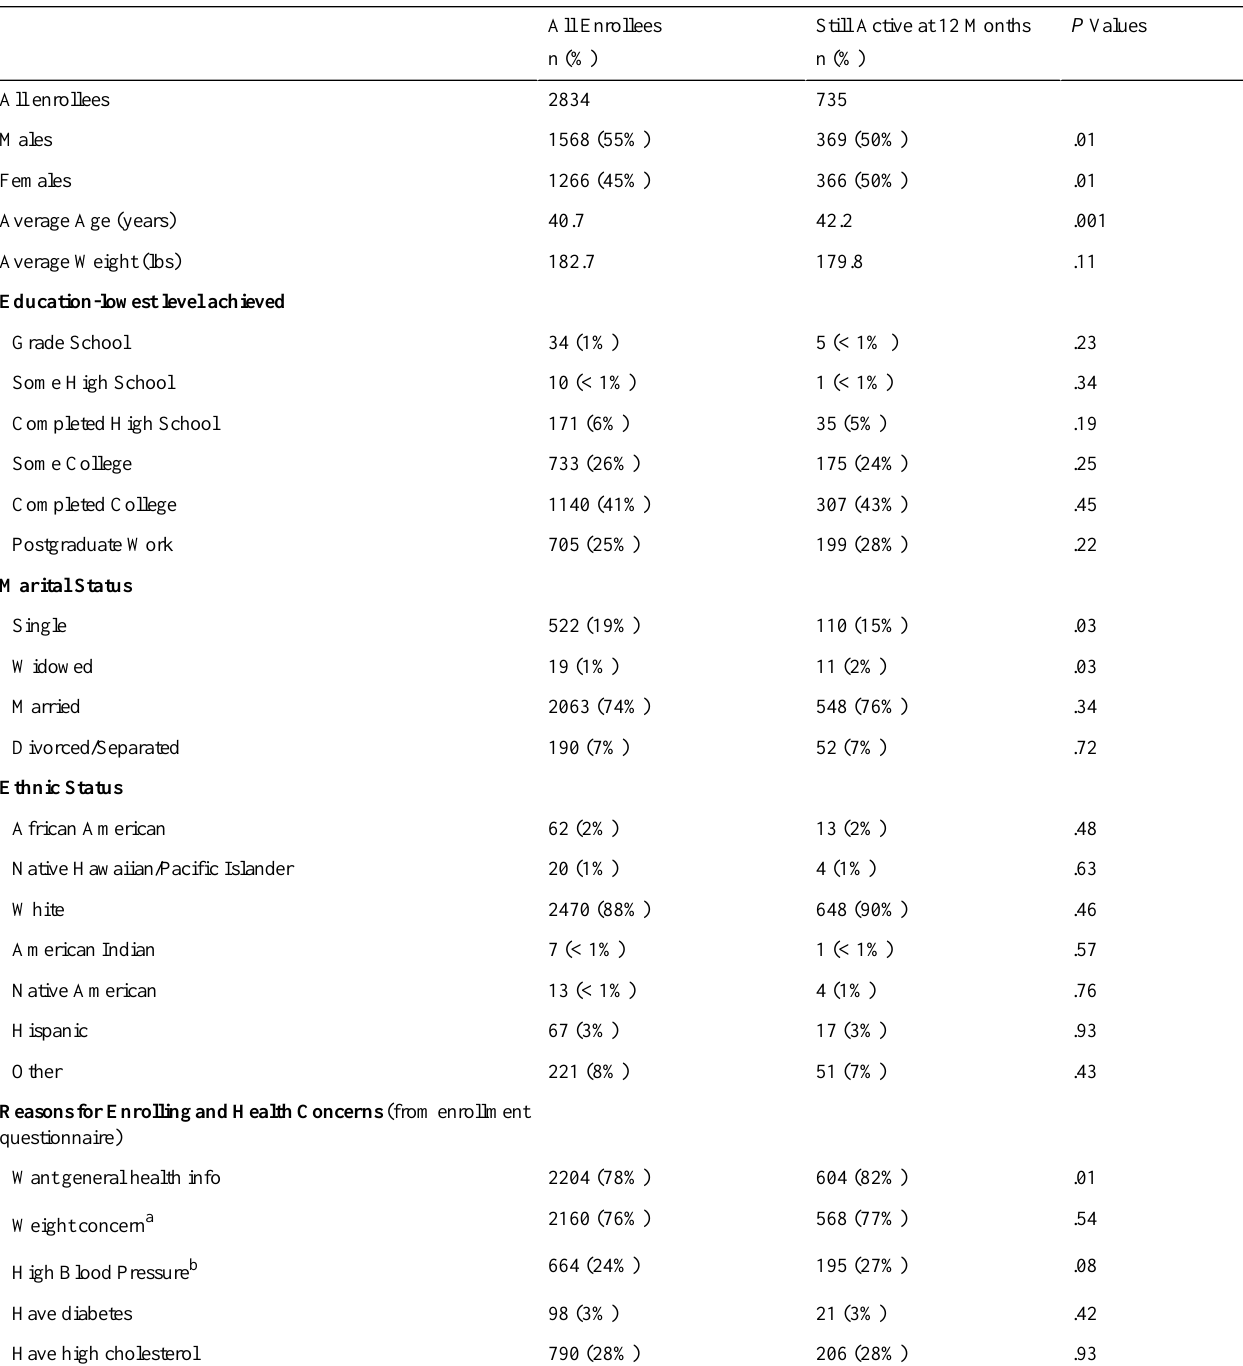
Table 1. Characteristics of all enrollees at baseline and of those still using the program at 12 months, using self-entered data at time of enrollment